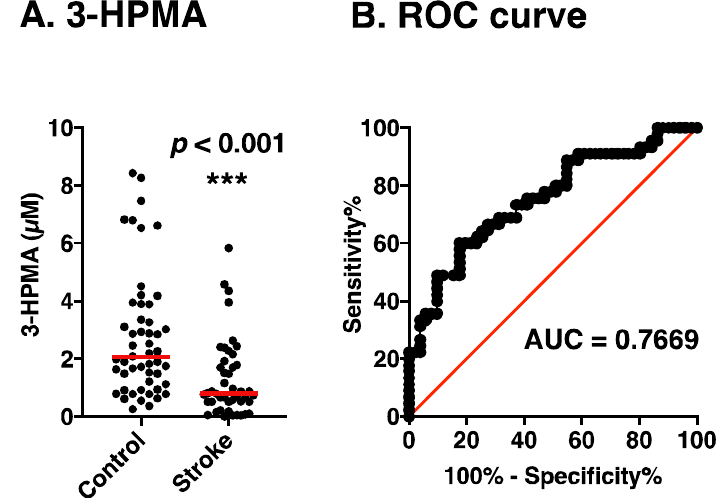
Figure 2. Comparison of the urinary level of 3-HPMA in control subjects and stroke patients. ( A ) The level of 3-HPMA in control and stroke patients was compared. Average value of two experiments is shown with median (horizontal line). The significance of di ff erence was calculated using unpaired t test with Welch’s correction. *** p < 0.001. ( B ) Receiver operating characteristic (ROC) curve of 3-HPMA for stroke patients vs. control subjects.